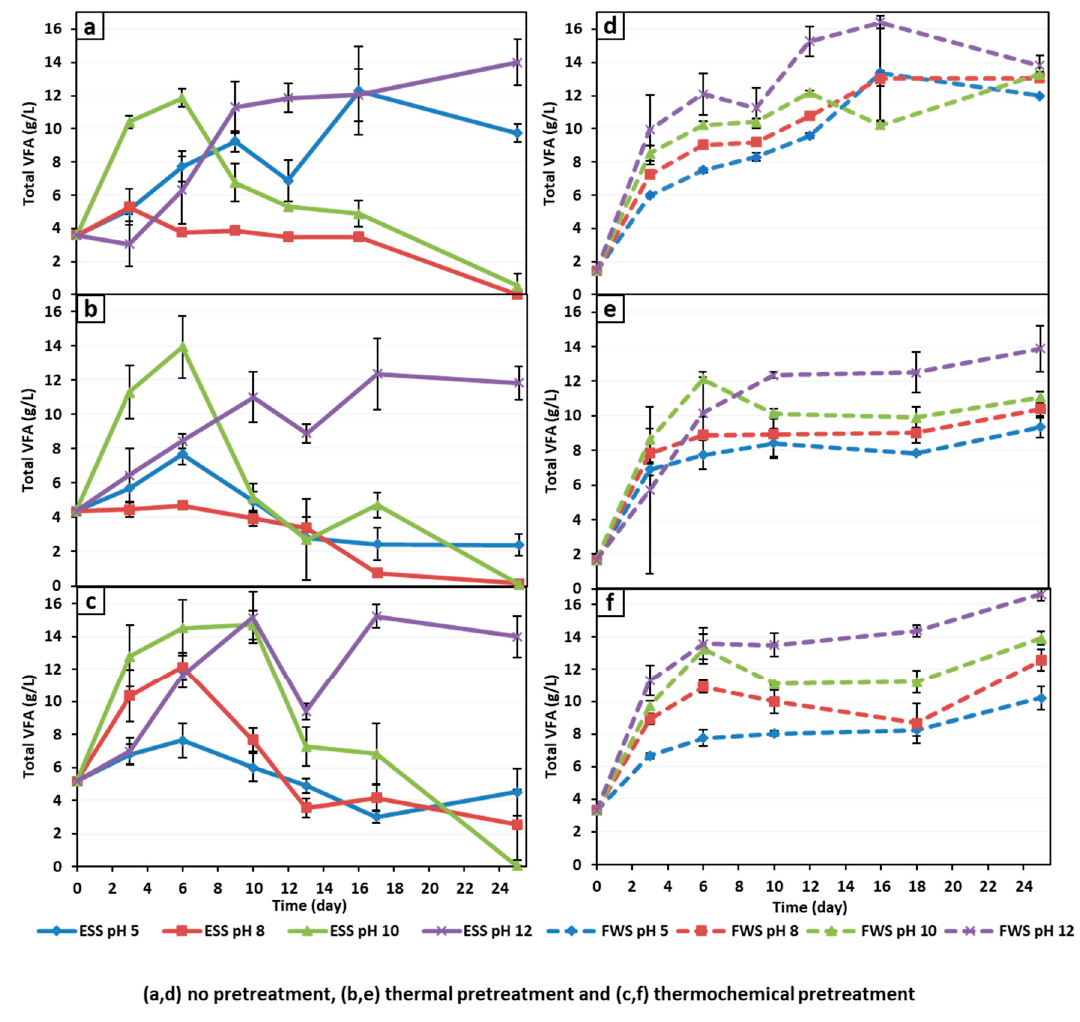
Figure 8. E ff ect of pretreatment on VFAs production from excess sewage sludge and food waste slurry.